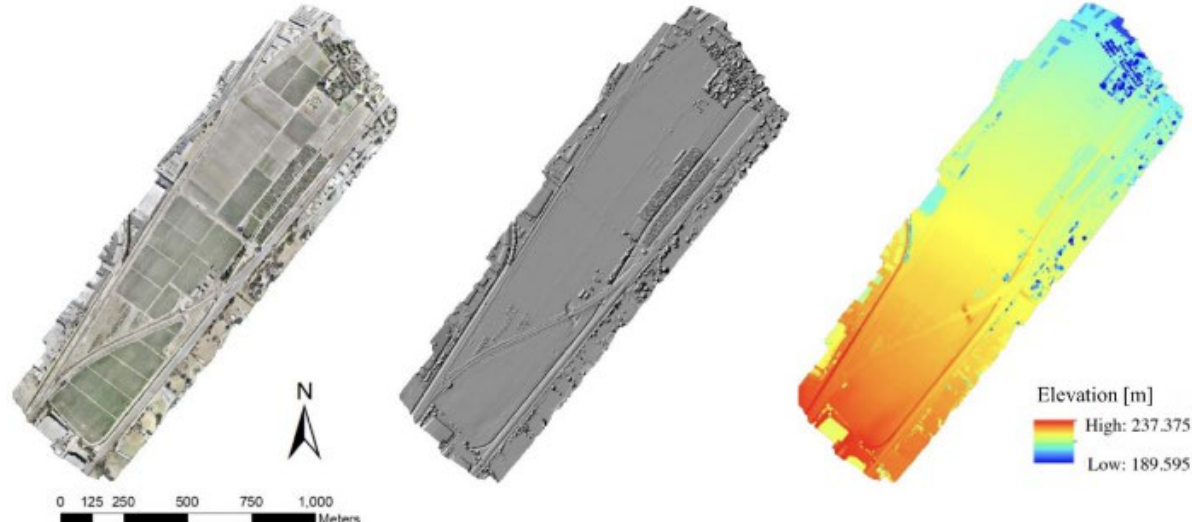
Figure 2 . Study area location within the city limits of Pomona in Los Angeles County, California,